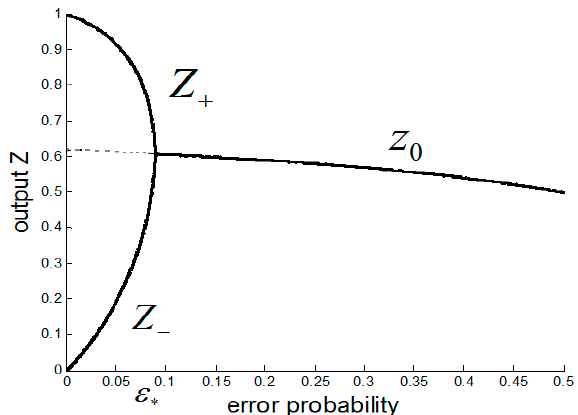
Figure 7. Bifurcation diagram for cascaded XOR gates and NAND gates. Appl. Sci. 2020 , 10 , x FOR PEER REVIEW